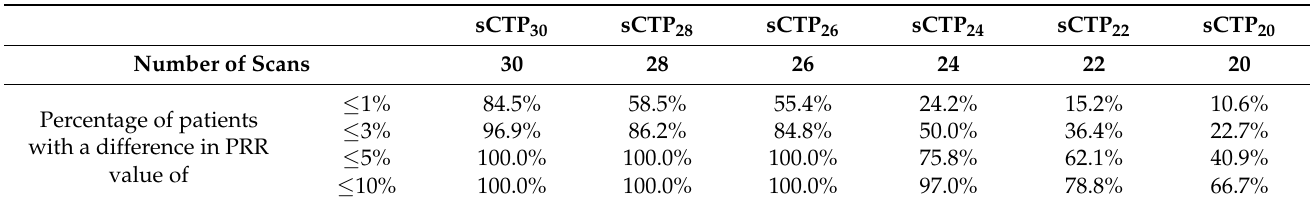
Table 2. The results of the comparative analysis of the PRR values of standard and simulated CTPs are given as the percentages of the simulated examinations, which present a deviation not exceeding 1%, 3%, 5% and 10%. sCTP 30 sCTP 28 sCTP 26 sCTP 24 sCTP 22 sCTP 20 Number of Scans 30 28 26 24 22 20 ≤ 1% 84.5% 58.5% 55.4% 24.2% 15.2% 10.6% Percentage of patients ≤ 3% 96.9% 86.2% 84.8% 50.0% 36.4% 22.7% with a difference in PRR ≤ 5% 100.0% 100.0% 100.0% 75.8% 62.1% 40.9% value of ≤ 10% 100.0% 100.0% 100.0% 97.0% 78.8%